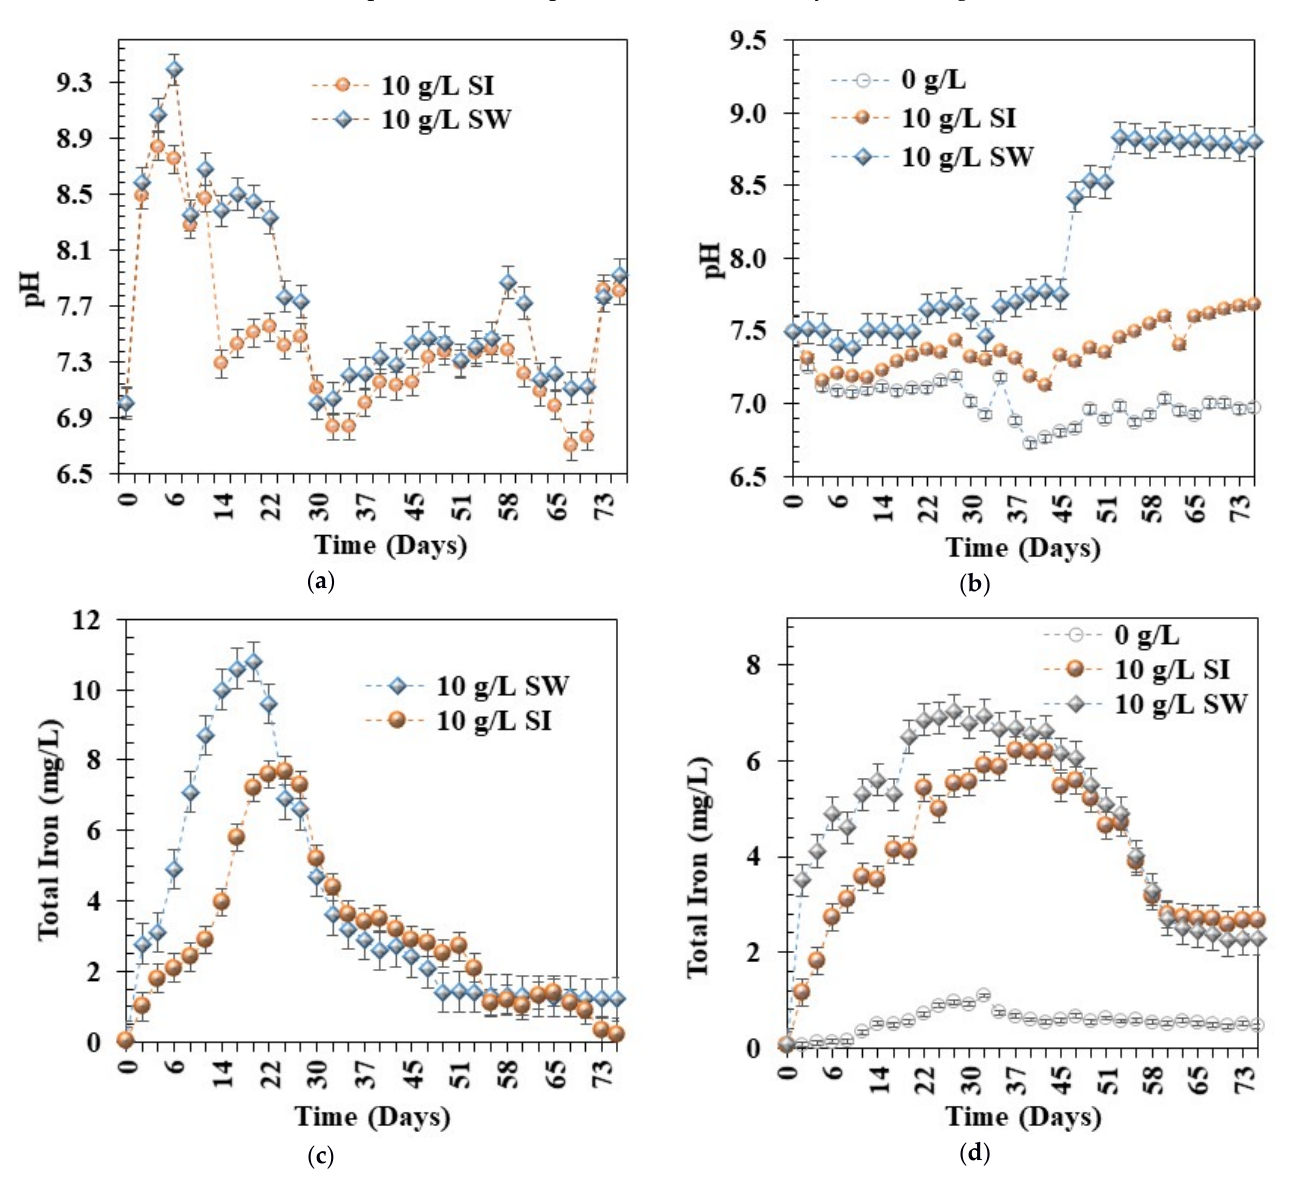
Figure 6. pH and total iron concentration variations resulting from 10 g/L of Fe 0 materials (SW or SI) dosage in distilled water or domestic sewage. ( a , c ) Fe 0 materials in distilled water; ( b , d ) Fe 0 materials in domestic sewage. Systems’ temperature, T = 37 ± 0.5 °C.